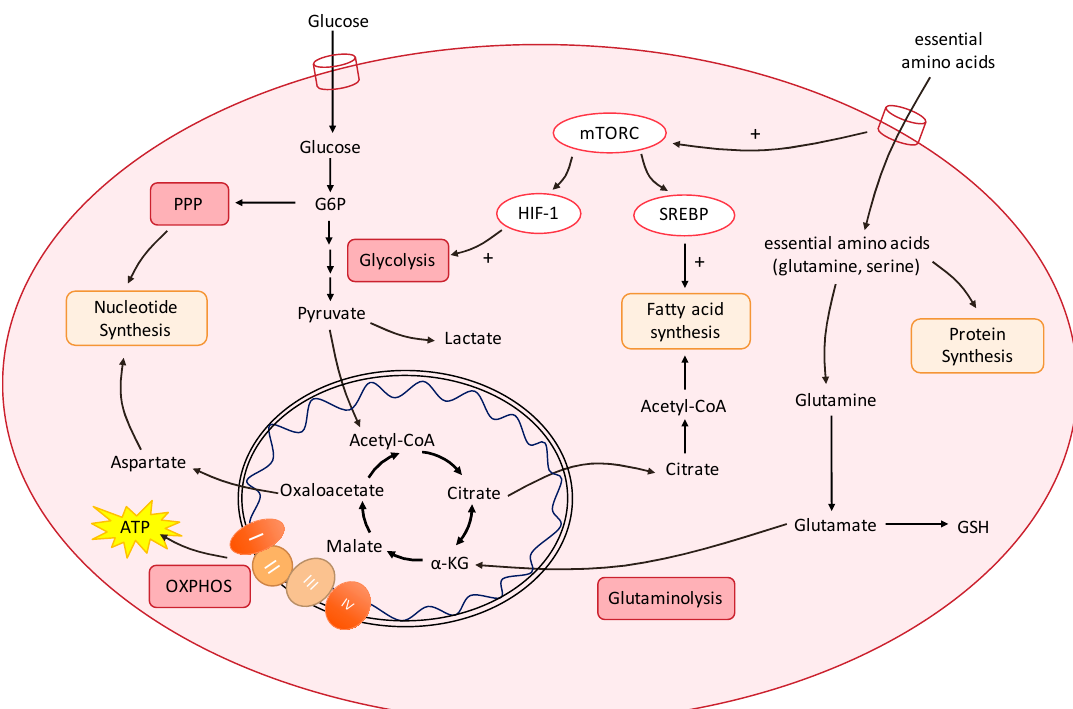
Figure 1. Overview of cancer cell metabolic reprogramming. Cancer cells require extensive metabolic reprogramming to fuel anabolic growth via increased nucleotide biosynthesis, protein synthesis, and FA synthesis. There is elevated glycolysis even under aerobic conditions (Warburg effect), which allows for the production of intermediates to be channelled into the PPP for nucleotide biosynthesis. However, a majority of tumours still retain oxidative capacity to produce ATP via OXPHOS. Glutaminolysis is also upregulated in many tumours for the production of α -KG to fuel the TCA cycle. Increased glutaminolysis also produces glutathione (GSH) to defend against oxidative stress. Central to these metabolic changes is the PI3K/Akt/mTOR pathway. Downstream effectors that are activated by mTORC signalling include the transcription factors HIF-1 and SREBP.